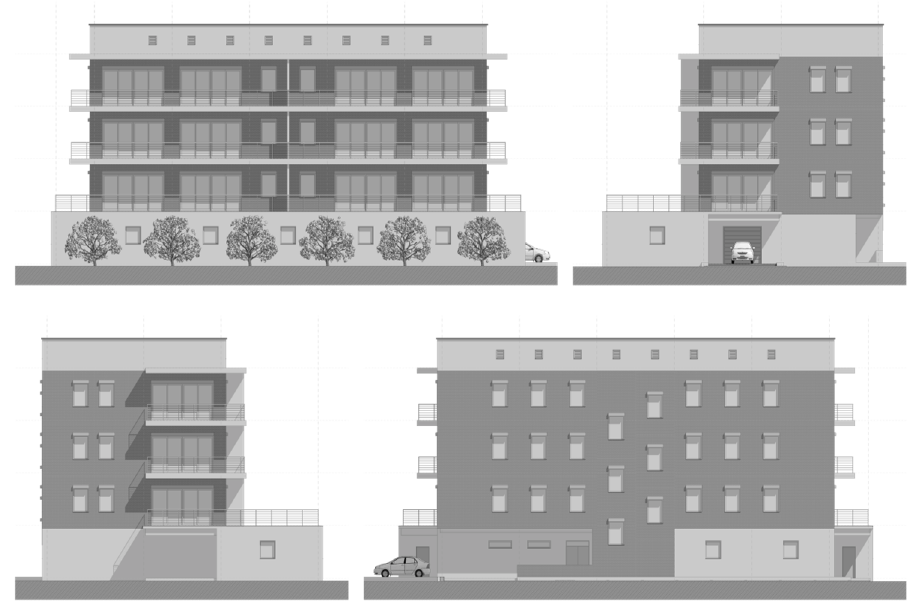
Figure 4. Elevations—large glazed surfaces facing south enable passive solar gains during winter.